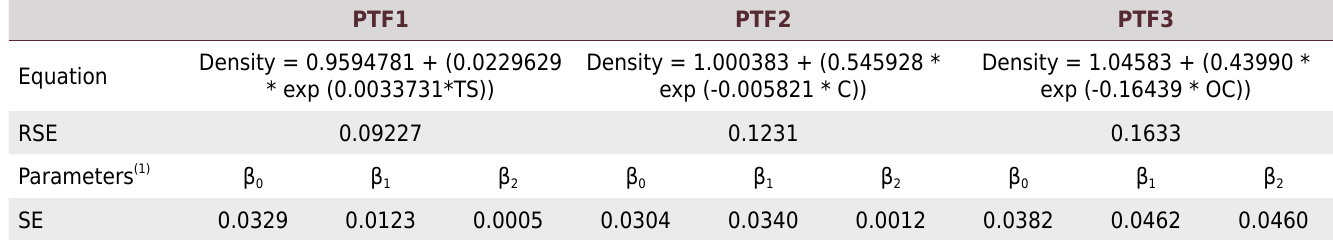
Table 2. Pedotransfer functions developed to predict the fine earth density and the respective model indexes. Density: fine earth density (g cm -3 ); TS: total sand (g kg -1 ); OC: organic carbon (g kg -1 ); RSE: residual standard error; SE: standard error of parameters; β 0 , β 1 , β 2 : parameters of the function. All PTF show the same degrees of freedom (129)